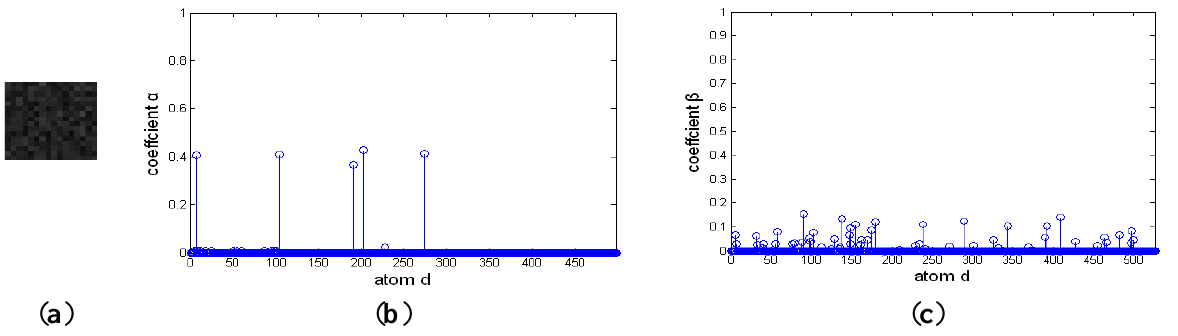
Figure 16. Representation coefficient of background block in multi-target image decomposed on discriminative over-complete dictionary. ( a ) Sparse coefficient on background dictionary, ( b ) Sparse coefficient on target dictionary.